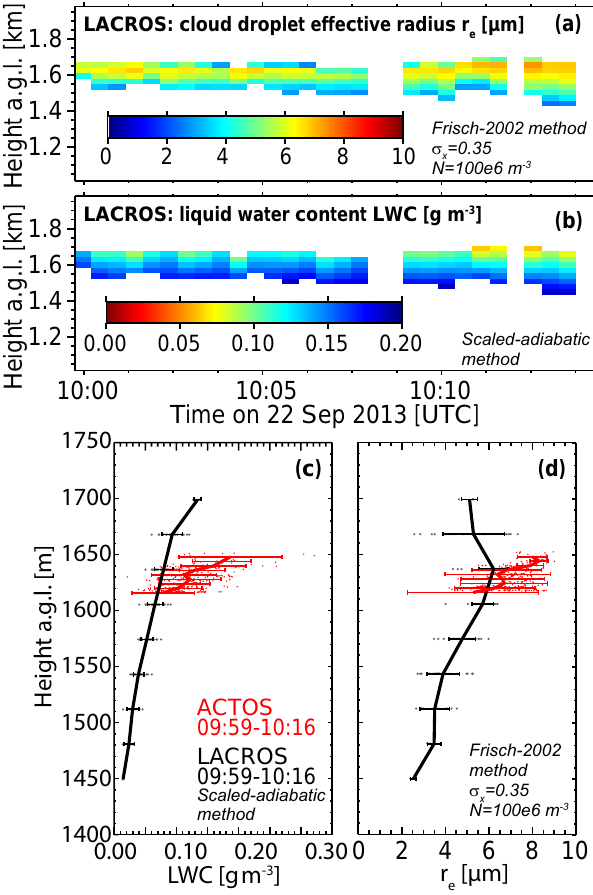
Figure 12. Stratocumulus observation at the Melpitz site on 22 September 2013. Time–height cross sections of (a) cloud droplet effective radius and (b) liquid water content as observed from ground-based remote sensing with LACROS. (c–d) Profiles of sin- gle data points, mean, and standard deviation (horizontal bars) of (c) liquid water content and (d) effective radius as observed in situ with ACTOS (red) and retrieved from LACROS (black) for the time pe- riod shown in (a) and (b) . Scaled-adiabatic method is based on Merk et al. (2016); Frisch-2002 method is based on Eq. (5) of Frisch et al. (2002).